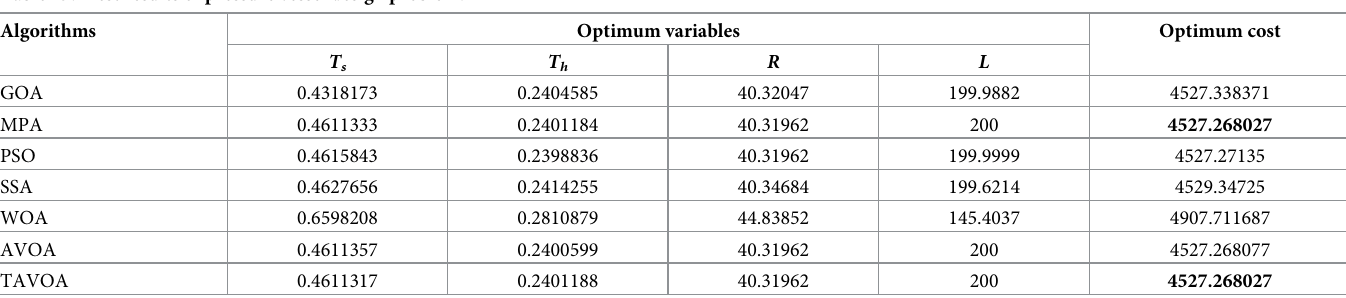
Table 17. Best results of pressure vessel design problem.